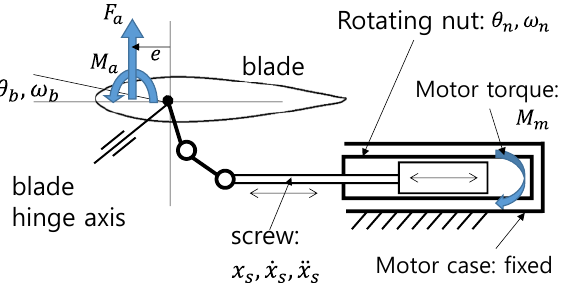
Figure 3. Blade pitch angle controlled by a linear actuator.